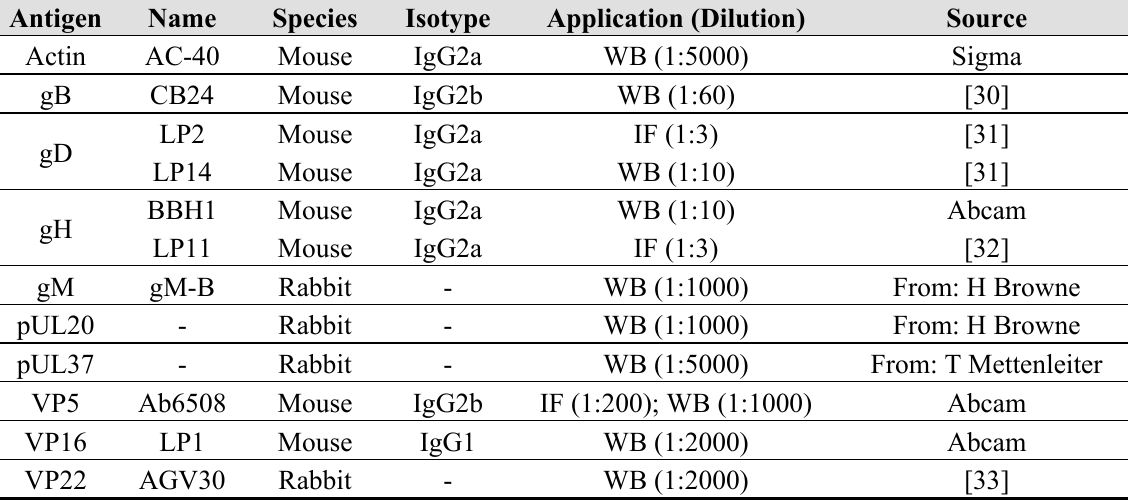
Table 2. Antibodies used for immunofluorescence (IF) microscopy and Western blotting (WB).